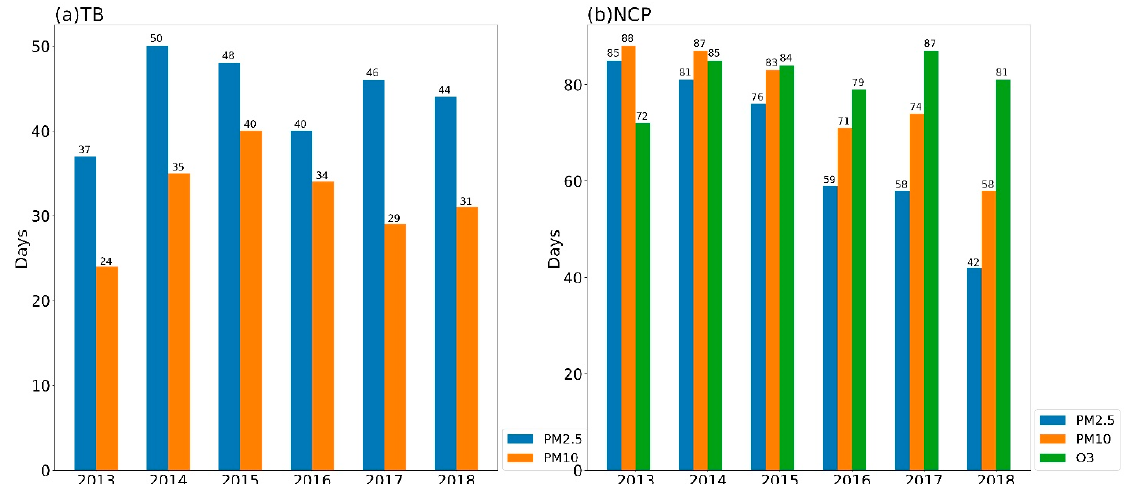
Figure 5. Days with pollutant concentrations exceeding the national first-level environmental standard in the Tarim Basin ( a ) and the North China Plain ( b ) in summer from 2013 to 2018.